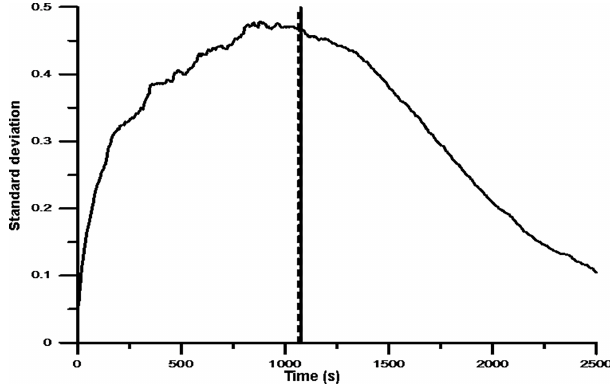
Figure 2. Time evolution of the probabilities of 4 of the 7 states for the initial condition P( 5 , 0 , 0 , 0 , 0 ; 0 ) = 1. Simulations were performed with the collection kernel K(i,j) = Cx i x j (with C = 5 . 49 × 10 10 cm 3 g − 2 s − 1 ) .